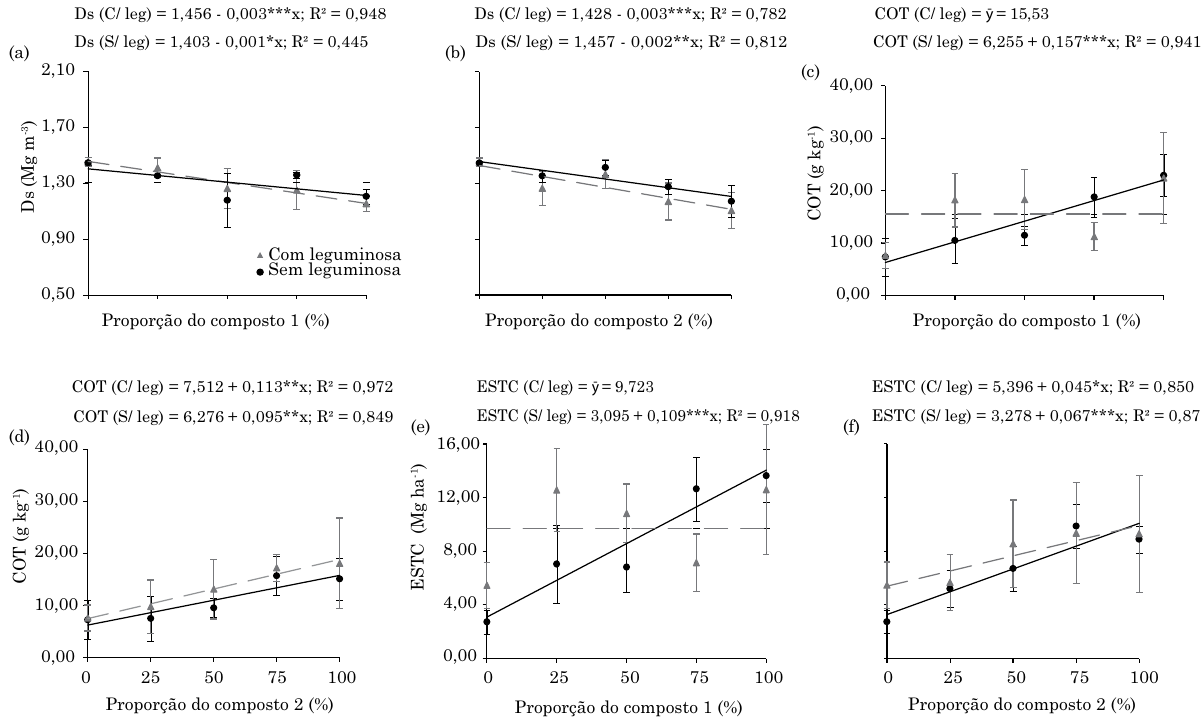
Figura 3. Densidade do solo (Ds) (a, b), carbono orgânico total (COT) (c, d) e estoque de carbono (ESTC) (e, f) após 30 dias da 1ª etapa da adubação do 2º ano agrícola (2010/2011) (profundidade de 0,00-0,05 m) em razão das proporções (%) do composto 1 (a) e composto 2 (b), na presença e ausência da leguminosa (feijão-de-porco). DMS (Tukey a 10 %) para o estudo do fator leguminosa nas proporções dos compostos - Ds: 0,2071; COT: 8,1925; e ESTC: 4,6575. Barras na vertical: erro- padrão. ***, ** e *: significativo a 1, 5 e 10 %,